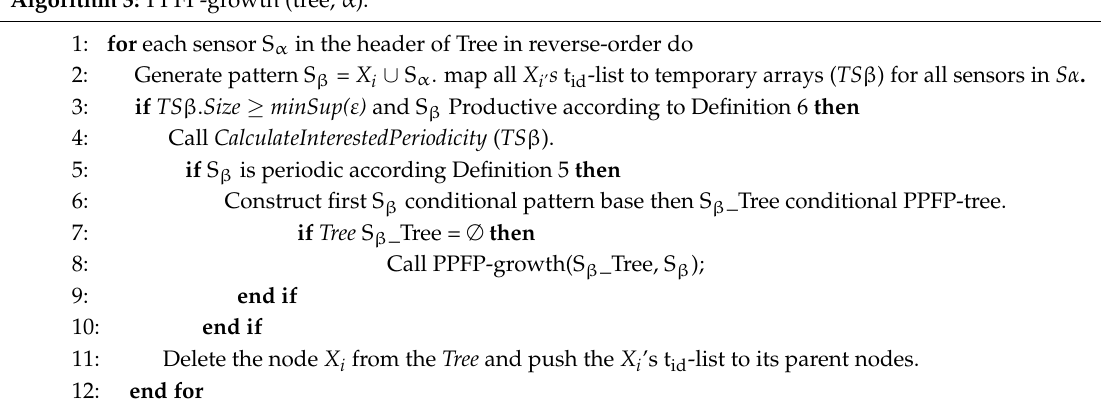
Algorithm 3: PPFP-growth (tree, α